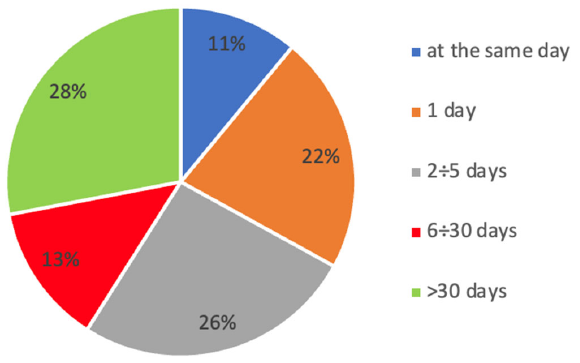
Figure 1. Percentage distribution of faults according to detection place.